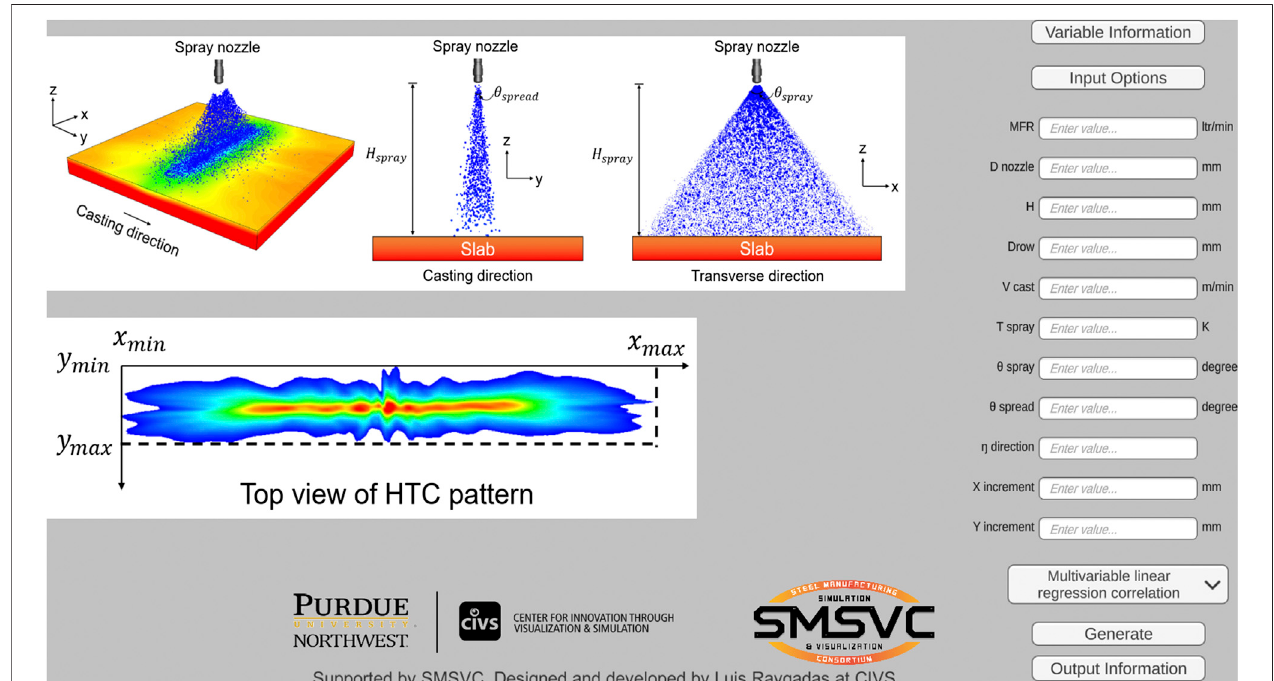
FIGURE 14 | Graphic User Interface of HTC